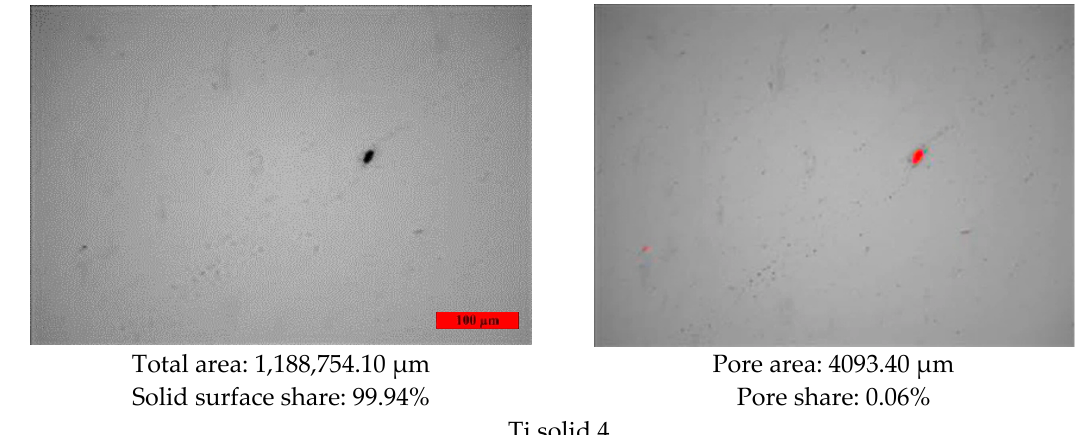
Figure 14. Results of measuring the share of pores for specimens of the Ti6Al4V alloy sintered by the SLS method (Ti solid 4 variant).